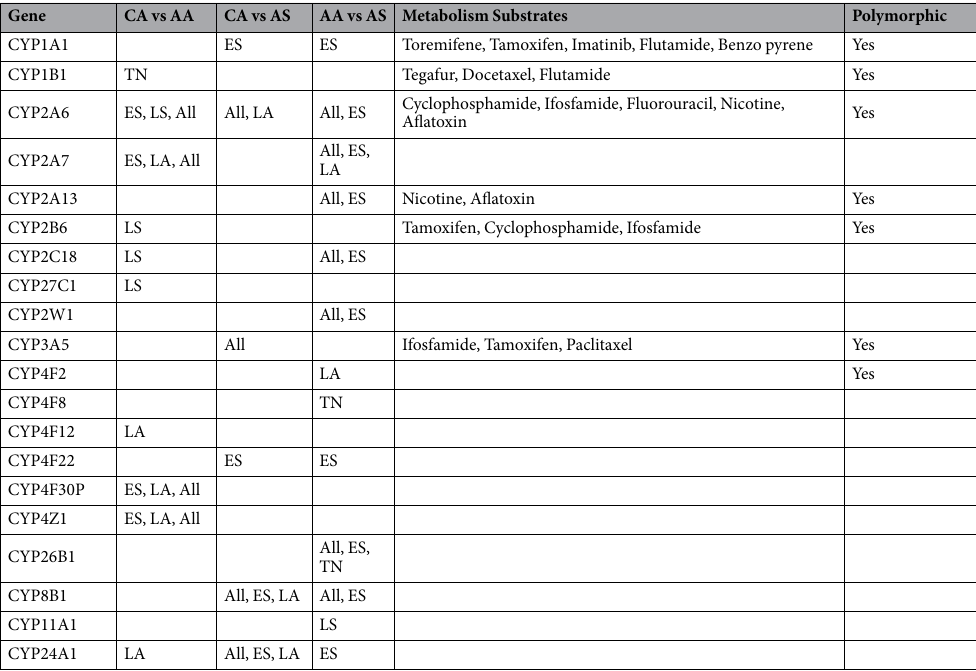
Table 1. Significantly differentially expressed (fold change >= 2 and adjusted p-value <= 0.05) CYP genes in various comparisons. For all the other DXME genes, see Supplementary material (Table S2). Column 2, 3 and 4 are for comparison between CA and AA, CA and AS, and AA and AS, respectively. In column 2, 3 and 4, we list the comparisons where the gene is significantly differentially expressed. All: overall comparison; ES: early stage (stage I, II); LS: late stage (stage III, IV); LA: luminal A; LB: luminal B; H2: HER2; TN: triple-negative. An ES in column CA vs. AS for gene CYP1A1 means CYP1A1 is significantly differentially expressed between early stage breast cancer in CA and early stage breast cancer in